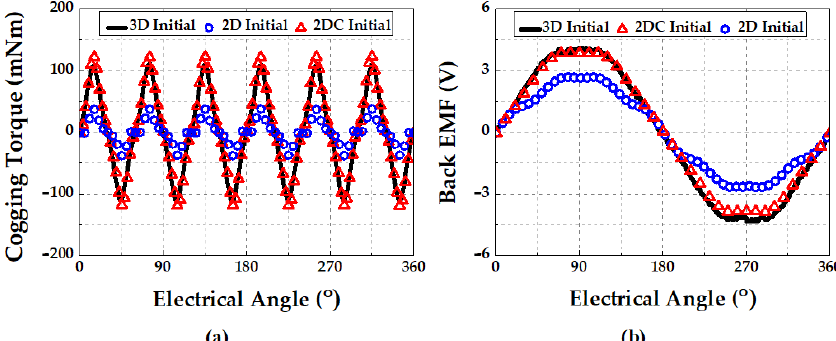
Figure 11. The 2D corrected model analysis results for the ( a ) cogging torque and ( b ) back EMF.